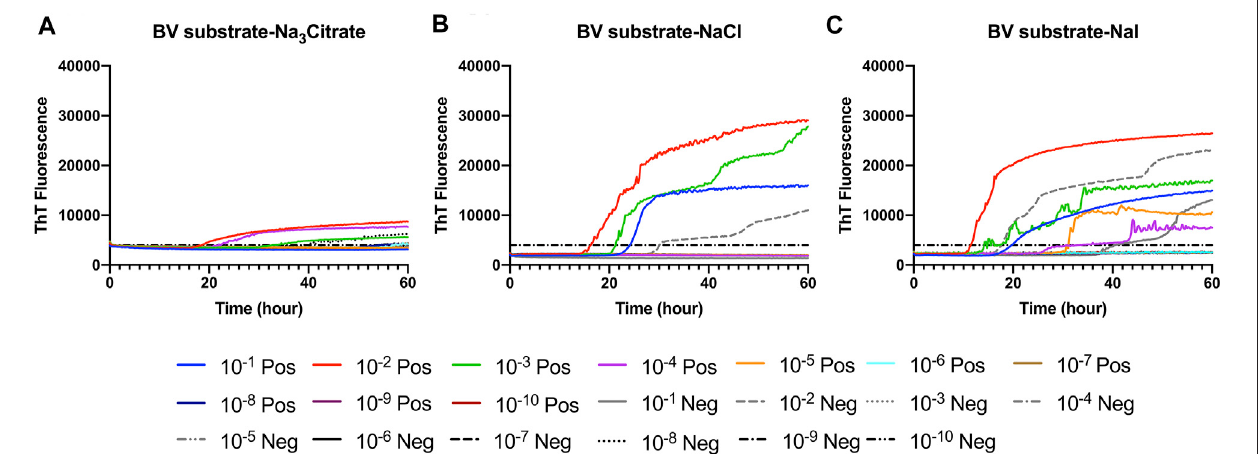
FIGURE1| RepresentativeHofmeisterioneffectsonRT-QuICreactionsseededwithCWD-positivewhite-taileddeerbrainsusing theBVrPrP substrate.RT-QuIC reactions were seeded with 10 − 1 , 10 − 2, 10 − 3 , 10 − 4, 10 − 5 , 10 − 6 , 10 − 7 , 10 − 8 , 10 − 9 , and 10 − 10 dilutions of brain homogenate from one CWD-positive and one CWD- negativewhite-tailed deer with the addition of 0.001% ofSDS. Substrate contained bank vole rPrP and 400 mM Na 3 citrate (A) ,NaCl (B) , or NaI (C) .Reactions were run at 42 ° C. Data are presented as a mean ThT fl uorescence of four repeated reactions.